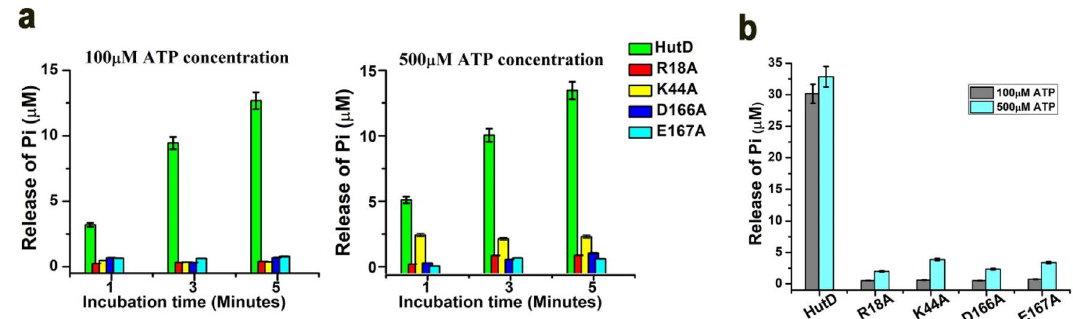
Figure 3. Identification of functionally crucial residues of HutD by mutagenesis. ( a ) Loss of function of the mutants R18A, K44A, D166A, E167A compared to HutD, as evident from the measurement of ATPase activities with 100 μM and 500 µM ATP at three time points (1, 3, 5 min). ( b ) ATPase activities of HutD and mutants measured with an extended incubation time of 20 min with 100 μM and 500 μM of ATP hydrolysis by HutD and calculations of V